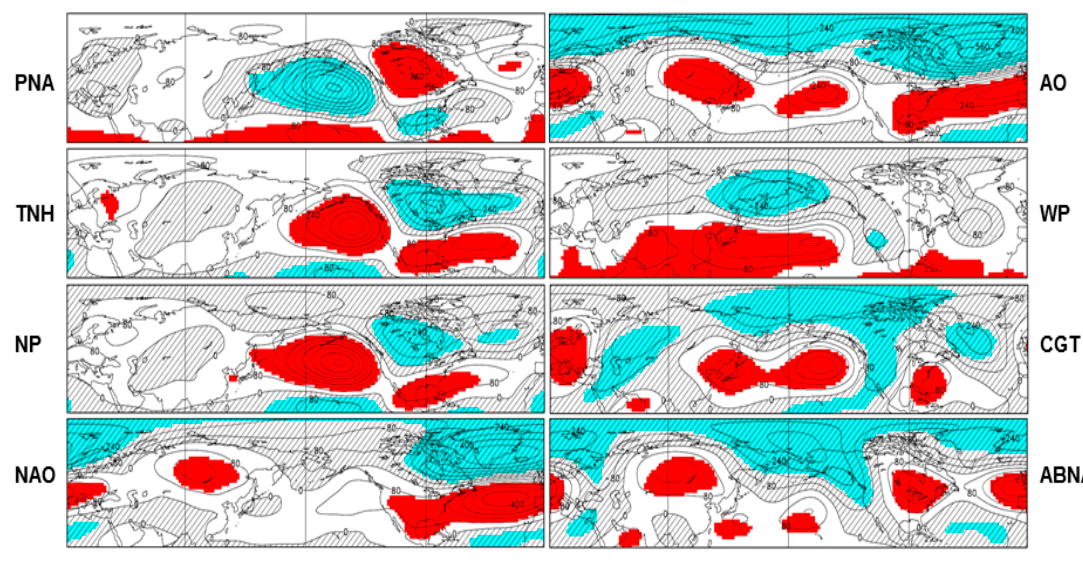
Figure 2. DJF mean anomalies of Northern Hemisphere extratropical Φ 500 (contours, interval 80 m 2 s − 2 , poleward of 15° N), regressed on the atmospheric pattern indices. The positive and negative geopotential anomalies, significantly correlated with the pattern index at the 5% level, are red- and cyan-shaded, respectively. Negative anomalies are also cross-hatched. Table 1. Correlation coefficients among the atmospheric pattern indices, as detailed in the text, over the 36 years. Numbers in bold indicate correlations significant at the 5% level, determined by a Student’s t-test, assuming one degree of freedom per year. Numbers above and below the diagonal are the results of the 36 DJFs and 36 JJAs, respectively. Correlations between the Tropical–Northern Hemisphere pattern (TNH) and other pattern indices are marked as “n/a” in JJA, since the TNH is not considered in summer. PNA TNH NP NAO AO WP CGT